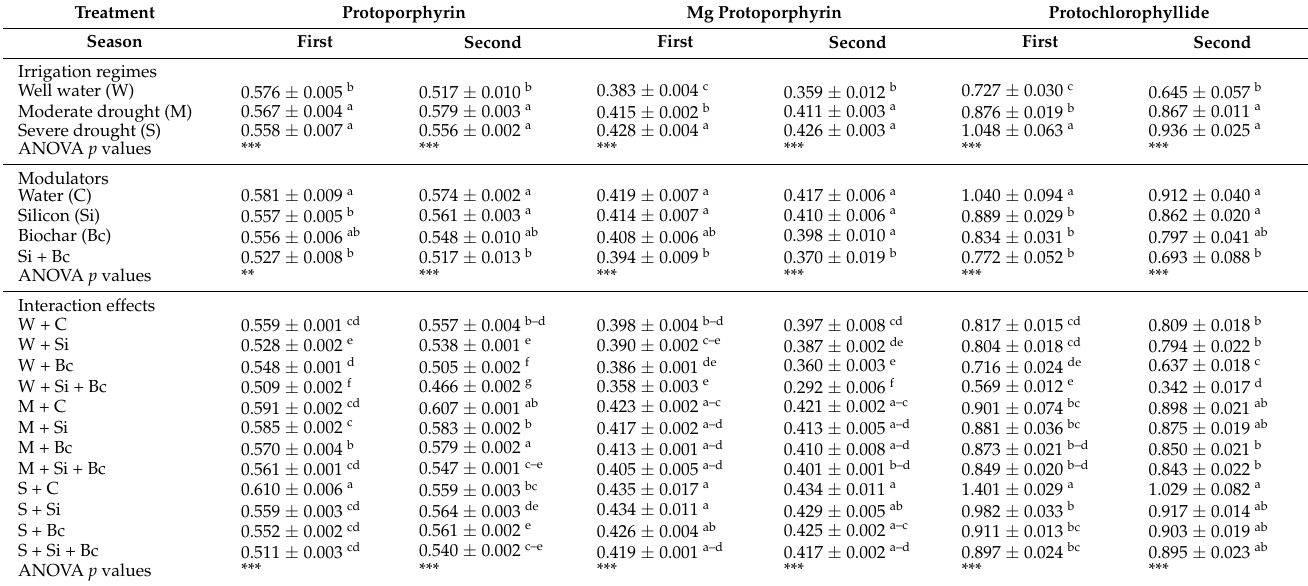
Table 7. Effect of irrigation regimes, silicon, biochar and their interaction on porphyrin intermediates of borage plants throughout two experimental